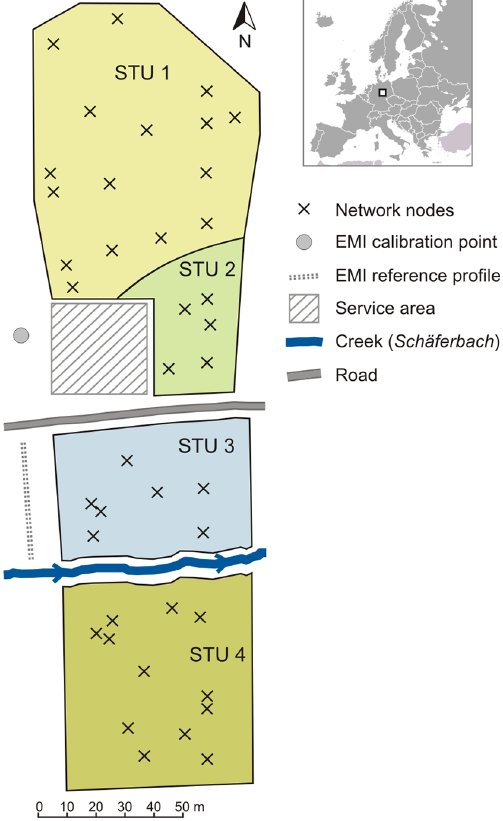
Figure 1. Schematic map of the Schäfertal hillslope site (Martini et al., 2015, modified): the position of the 40 nodes of the wireless soil moisture and soil temperature monitoring network is indicated, as well as the spatial extent of the four soil topographic units (STUs). EMI calibration point (grey dot) and reference profile (dashed line) are indicated in the eastern part of the